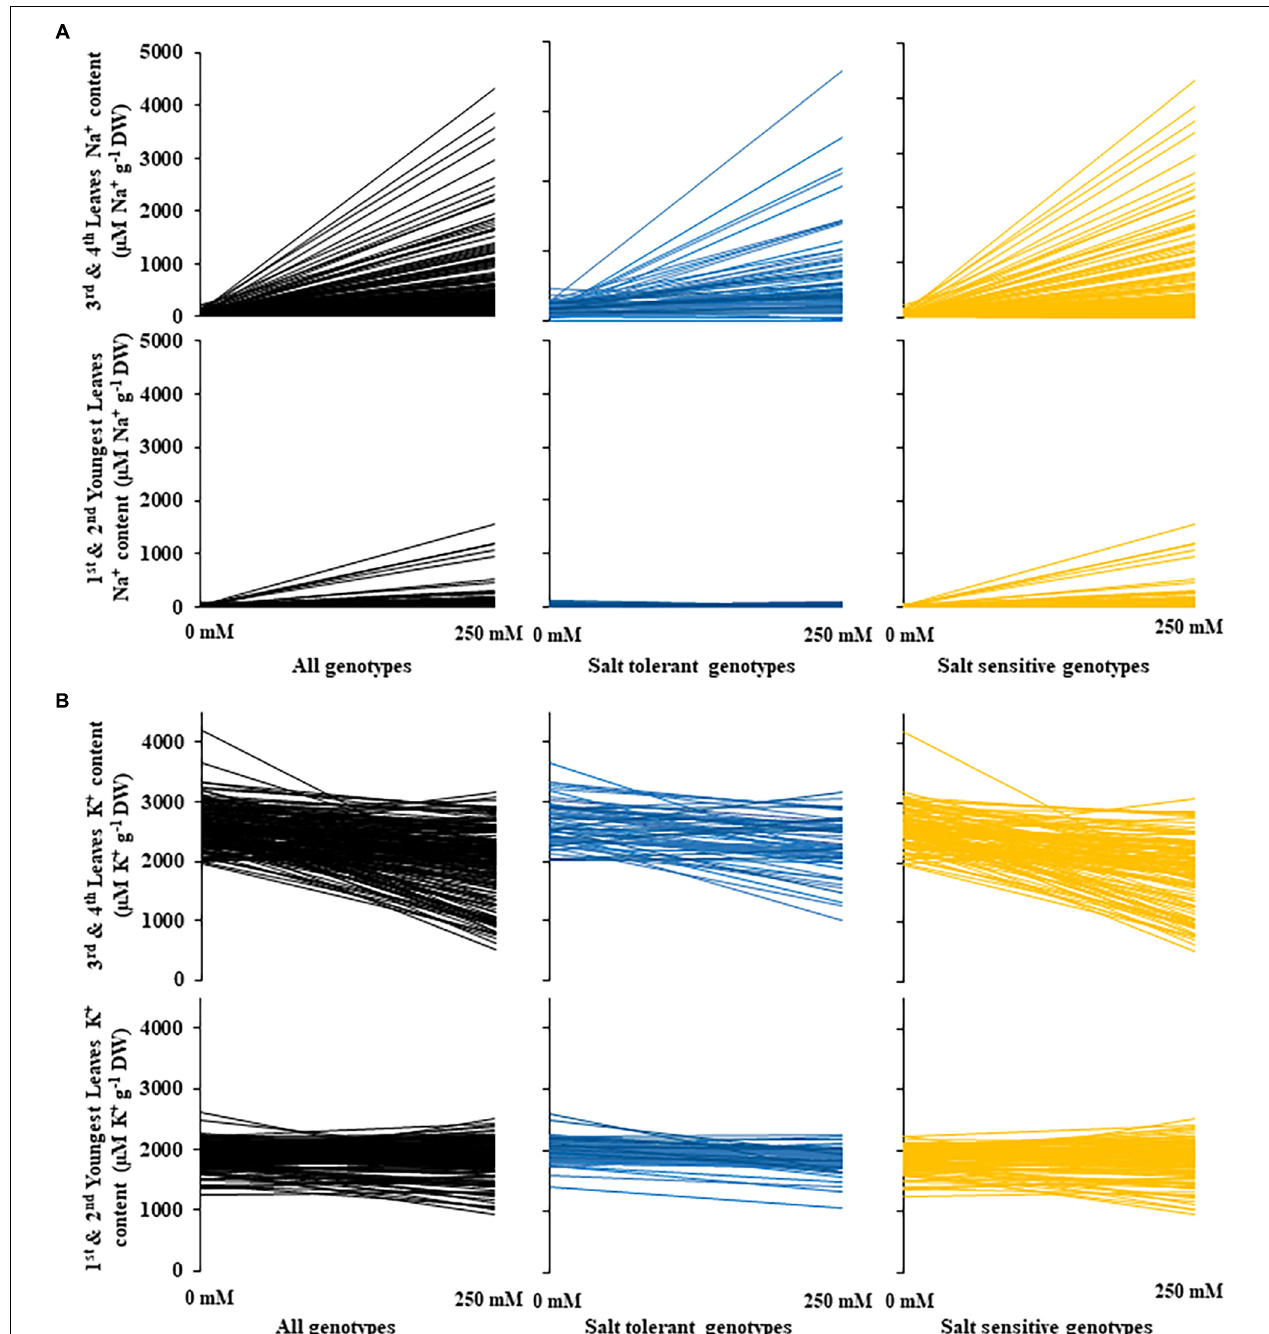
FIGURE 5 | Changes in sodium and potassium leaf content between control and salt (NaCl) treatments for 200 diverse safflower genotypes. (A) Sodium content of safflower genotypes under control (0 mM) or salt (250 mM) treatments; sodium content of the third and fourth leaves in the upper panel and sodium content of the first and second youngest expanded leaves in the lower panel. (B) Potassium content of safflower genotypes under control (0 mM) or salt (250 mM) treatments; potassium content of the third and fourth leaves in the upper panel and potassium content of the first and second youngest expanded leaves in the lower panel. Black – all genotypes; blue – salt tolerant genotypes; and yellow – salt sensitive